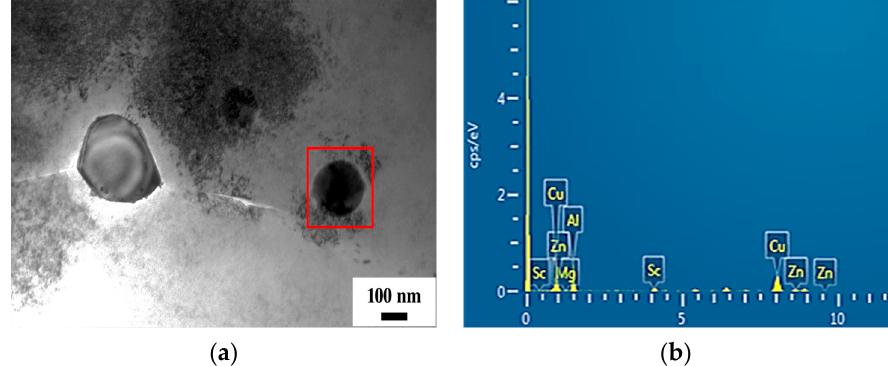
Figure 4. Morphology and energy spectrum analysis of precipitated phase in T6 alloy.